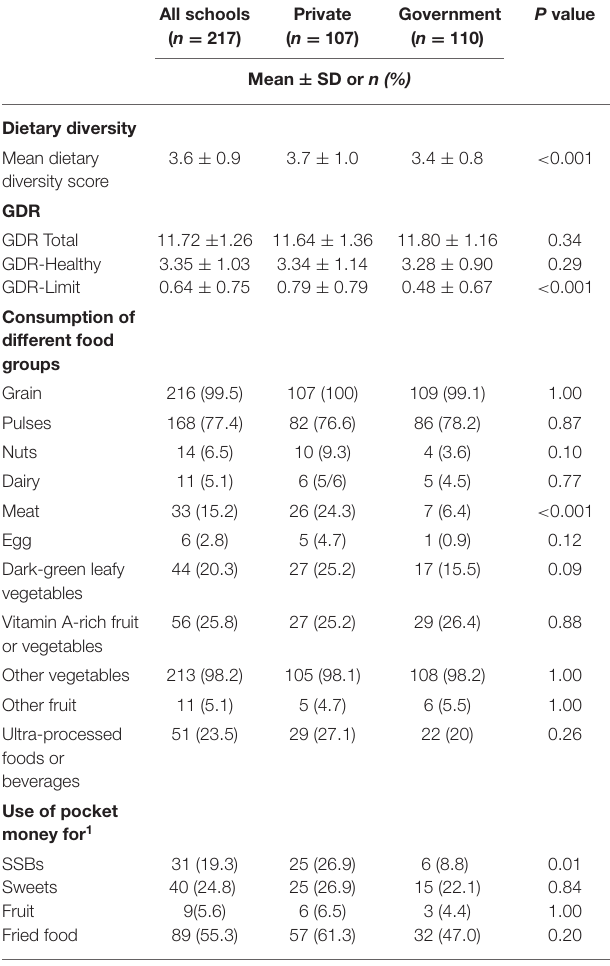
TABLE 2 | Dietary and purchasing behavior of study participants: consumption and purchase by food group and level of processing (total and separated by school